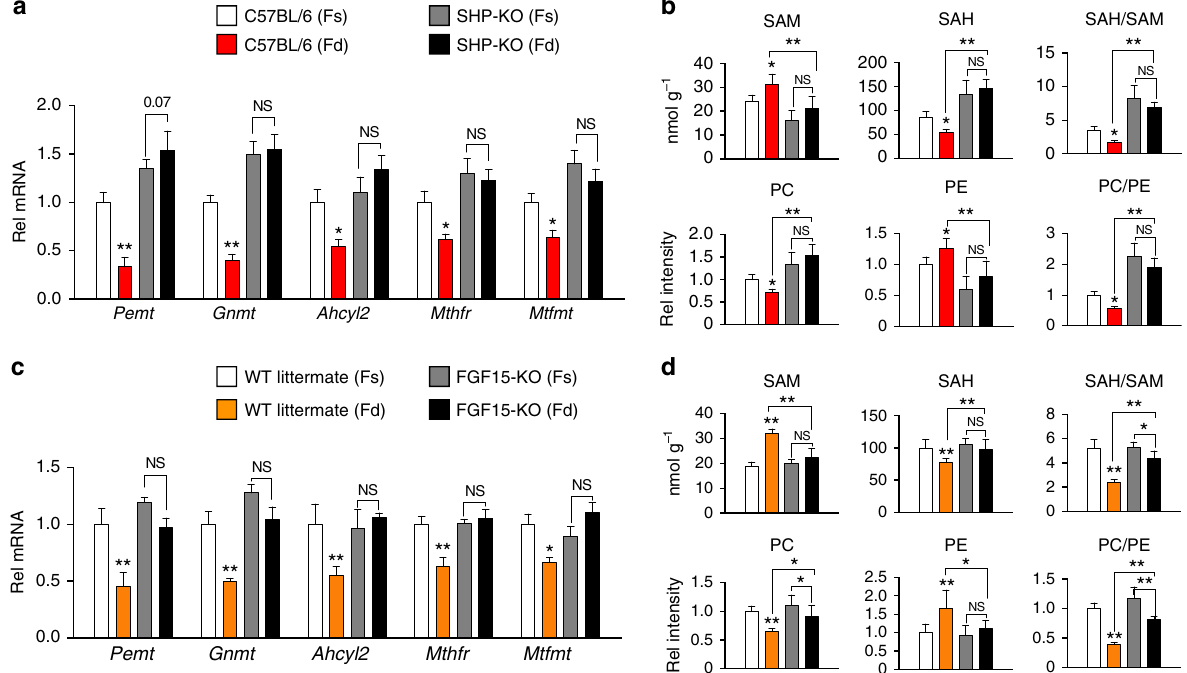
Fig. 2 FGF15 and SHP are physiological repressors of PC production in the fed state. C57BL/6 mice and SHP-KO mice ( a , b ) or FGF15-KO and WT littermate ( c , d ) mice were fasted for 12 h (Fs) or fasted and refed for 6 h (Fd). Hepatic mRNA levels of selected 1C cycle genes ( a , c ) and 1C cycle metabolites ( b , d ) were measured by qRT-PCR and LC – MS analysis, respectively. Means ± SD are shown ( n = 5 mice), and statistical signi fi cance was measured using the two-way ANOVA with the FDR post-test and * P < 0.05, ** P < 0.01, NS, not statistically signi fi